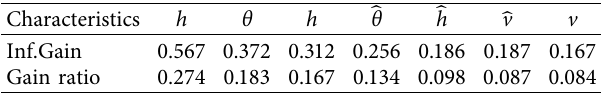
Table 2: Ranking of information gain/information gain rate of each feature of longitudinal motion behavior classification.